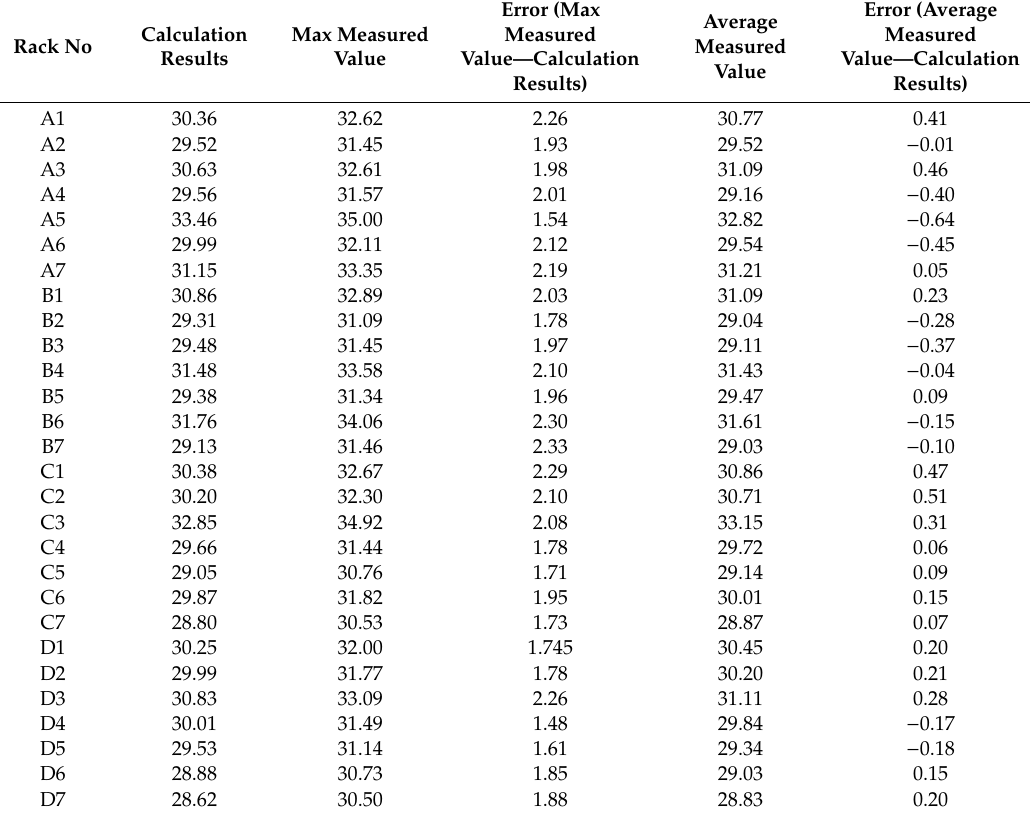
Table 23. Relationship between the calculation results at each rack intake temperature and the maximum and average values of the measured values during the evaluation period.